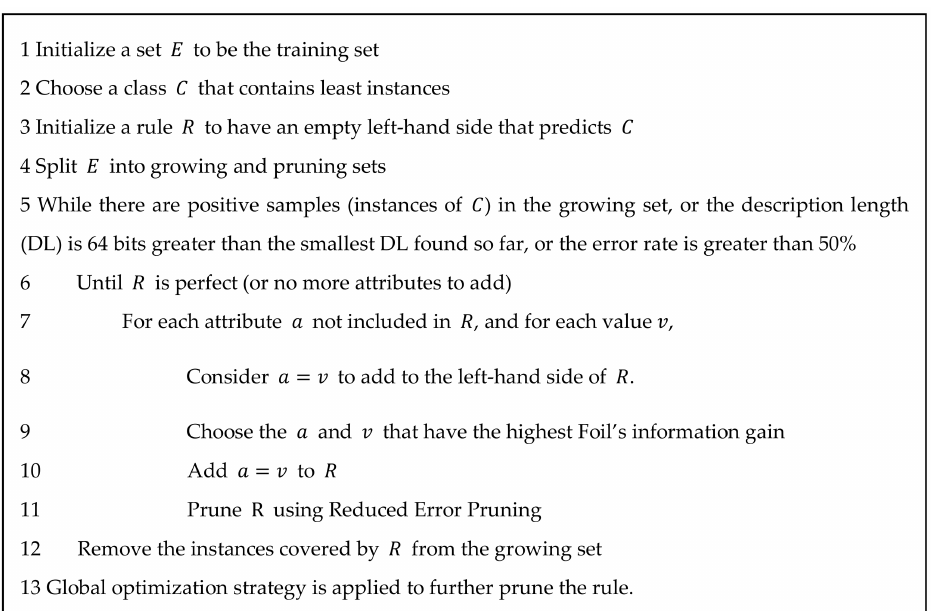
Figure 2. The procedures of RIPPER